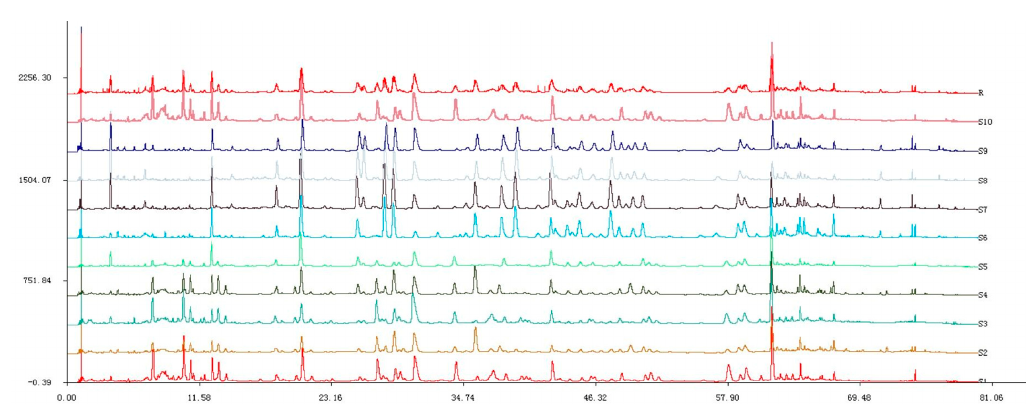
Figure 3. UPLC chromatographic fingerprints of 10 R. rugosa samples.